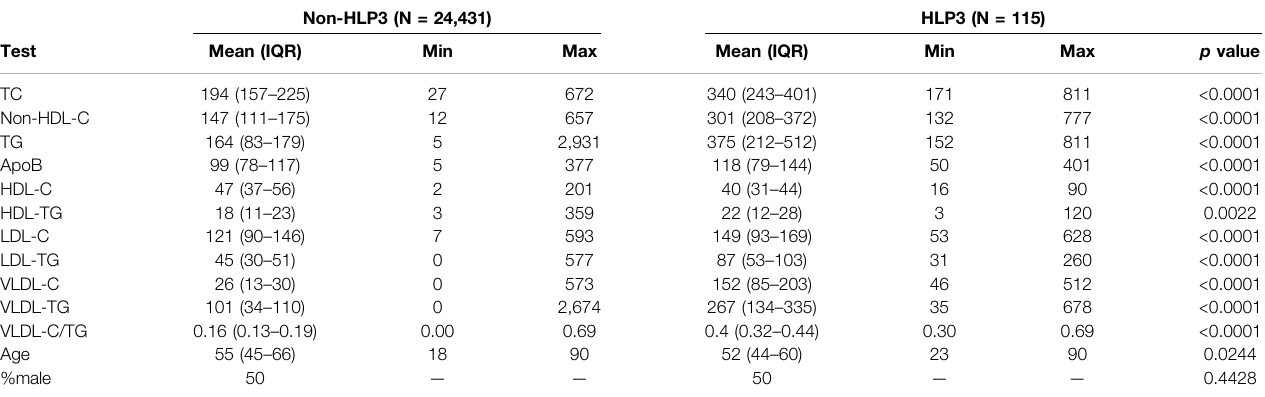
TABLE 1 | Lipid test values and demographics of the patient